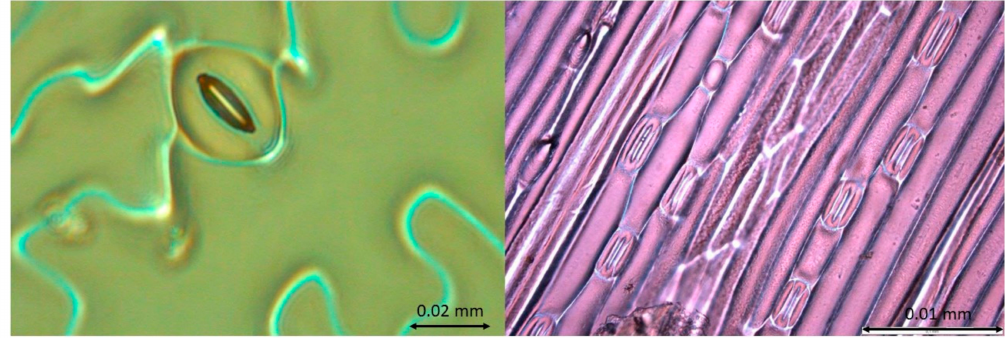
Figure 2. Kidney-shaped stoma of Ocimum basilicum L. ( left ) and dumbbell-shaped stoma of grasses ( right